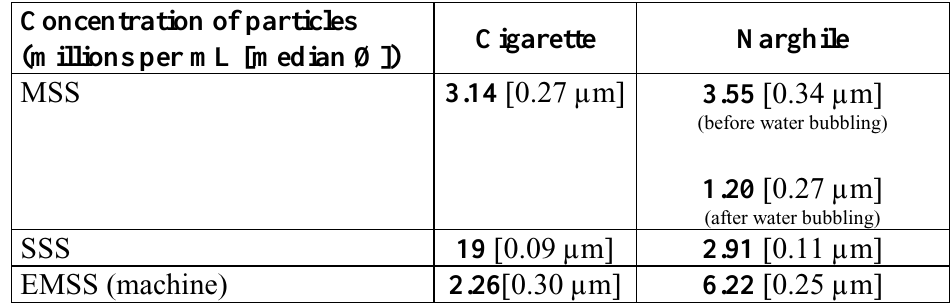
Table 1. Concentration of particles (millions per mL [median Ø]) through the use of a smoking machine (from Becquemin et al.